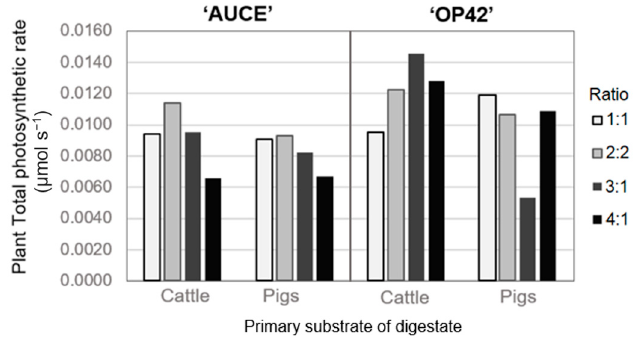
Figure 7. Leaf total photosynthetic rate in August depending the clone of poplar, primary substrate of digestate, and different ratios of wood ash and digestate.